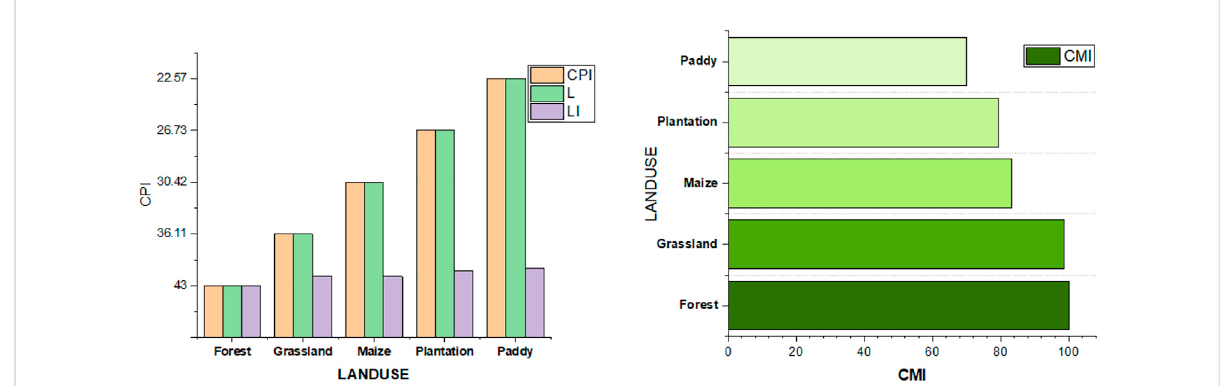
FIGURE 6 Effect of land use on carbon management index in 0 – 40 cm soil depth. Error bars indicate the least signi fi cant difference (LSD) values at p =